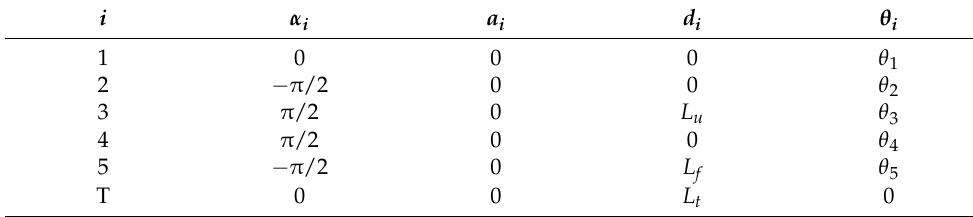
Table 4. DH parameters of Pepper’s arm.